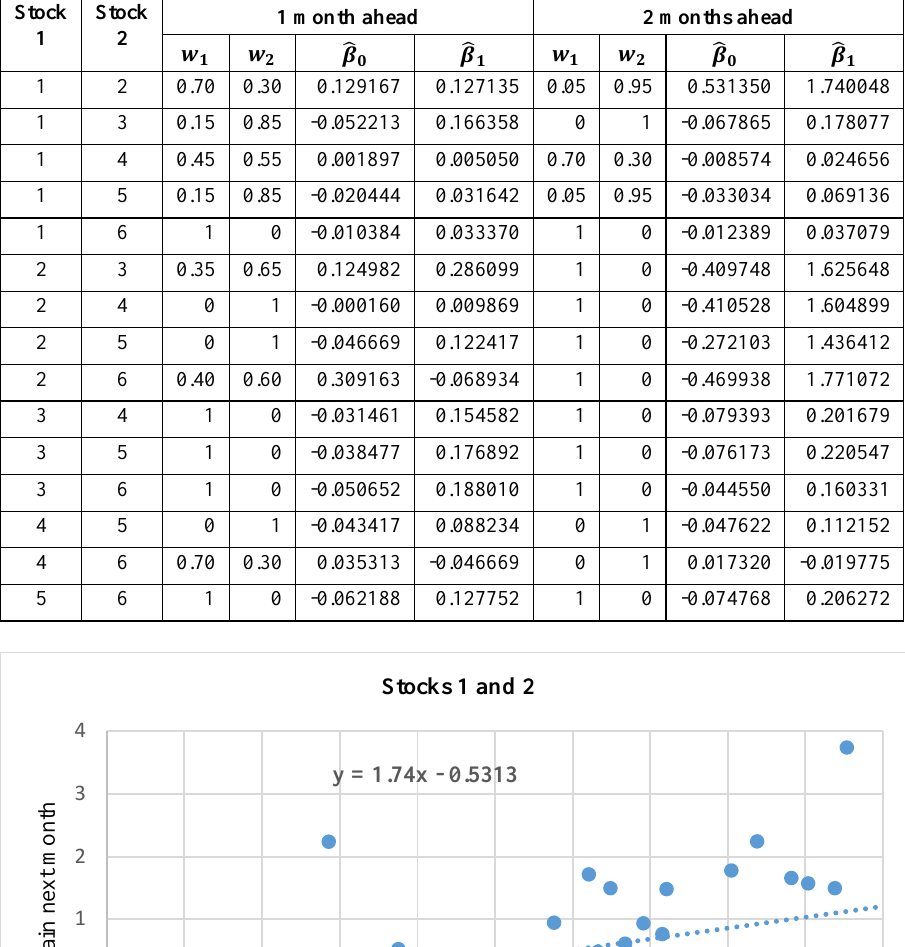
Table 3. The maximum values of the slope 𝛽̂ 1 and the corresponding intercept 𝛽̂ 0 of the regression of (1∗) on 𝑃 (𝑘) , 𝑘 = 1,2, for the 15 possible pairs of stocks. 𝑔 𝑗 𝑤 𝑗 𝑤